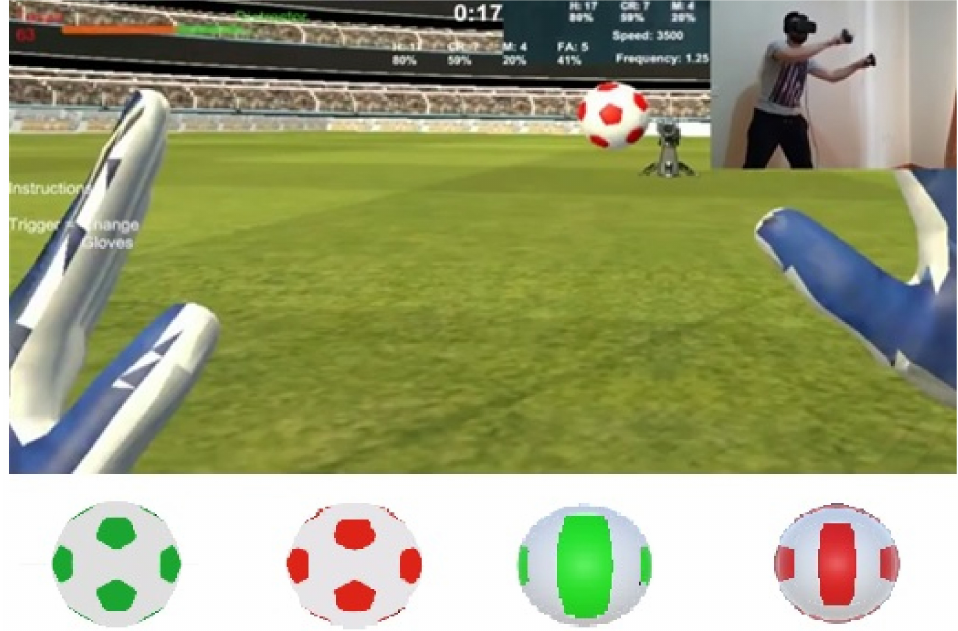
Figure 1. Game play screenshot of the VR Goalkeeper task with the four types of balls used. The Attention Network Test (ANT) . Participants completed the adult version of the Attention Network Test [13] on a desktop computer. Each trial in the ANT entails the presentation of a central arrow on the screen and requires participants to click the left or right mouse button to indicate the arrow’s pointing direction (Figure 2). Four flanker arrows are also presented, two on each side of the central arrow, pointing to the same or different direction, creating thus trials that are congruent or incongruent. Neutral trials in which the central arrow is flanked by lines without an arrow cap are also